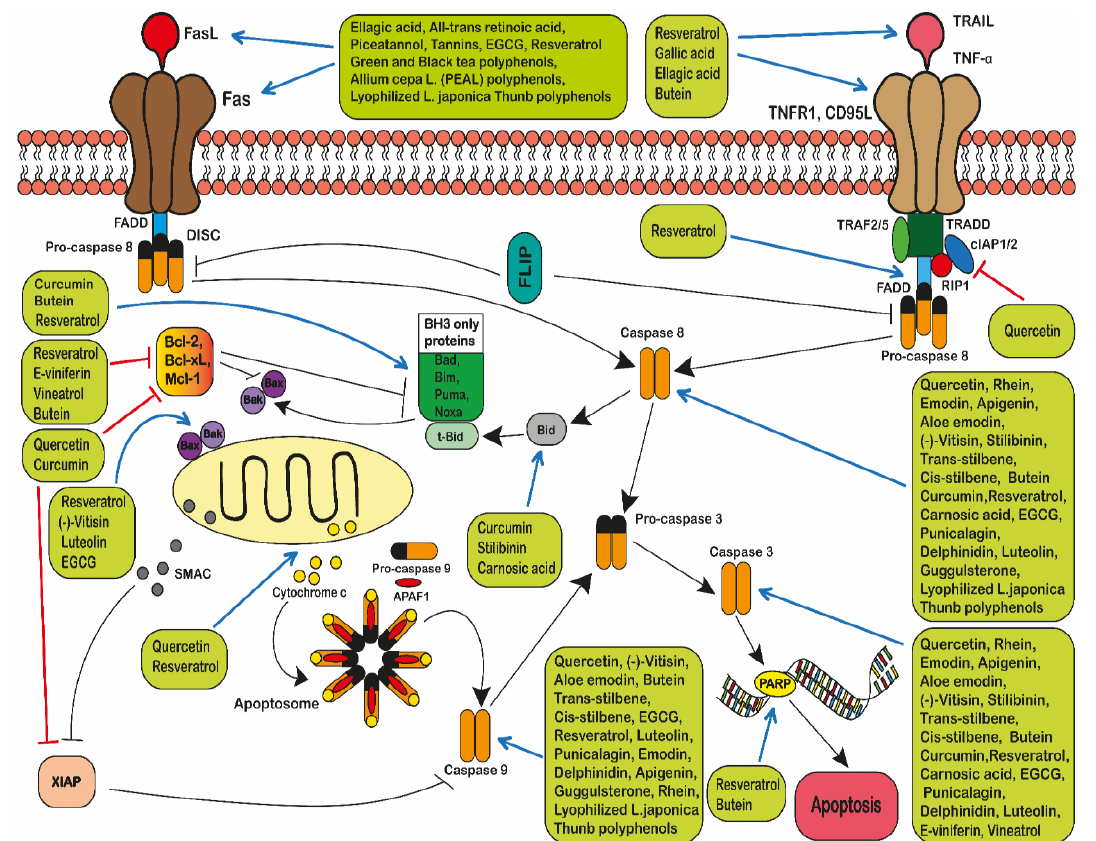
Figure 6. The modulation effect of polyphenols on the intrinsic and extrinsic pathways of apoptosis. The extrinsic death receptor pathway activates by the death receptor ligands such as FasL ( dark red ), TNF- α or TRAIL ( light red ). The binding of FasL to Fas ( dark brown ) recruits FADD ( light blue ) and pro-caspase-8 ( orange and black ), forming the DISC complex, which activates caspase-8 and then caspase 3. The binding of TNF- α ( light red ) to TNFR1 ( light brown ) recruits TRADD ( dark green ), RIP ( red ), TRAF2/5 ( light green ) and cIAP1/2 ( blue ) to form the complex, which in turn binds to pro-caspase 8 and then activates caspase 8. The intrinsic death receptor pathway is initiated by BH3-only protein ( green ), which can inactivate Bcl-2 ( dark orange ) and prevent Bcl-2 from effectively neutralizing Bax ( dark purple ) and Bak ( light purple ) and activates them. The Bax and Bak activation on the mitochondrial membrane leads to release of second mitochondria- derived activator of caspase a mitochondrial protein (SMAC) ( dark grey ) and cytochrome c ( yellow ) to the cytoplasm. The cytoplasmic cytochrome c then associates with Apaf-1 ( red ) and pro-caspase 9 to form the apoptosome, which activates caspase 9 and caspase 3, leading to apoptosis. Caspase 3 in turn initiates the cleavage of the nuclear enzyme PARP ( yellow ) which recognises damaged DNA, and initiates apoptosis if DNA damage is not repaired. Finally, SMAC is able to regulate apoptosis by inhibiting the inhibitor of apoptosis protein (XIAP). The effect of a variety of polyphenols ( shown in lime green ) is shown on both genes and proteins level regulating the intrinsic and extrinsic pathways of apoptosis. The blue arrows indicate the induction or activation of a protein or genes; whilst the red line shows the depletion or inhibition of a protein or gene